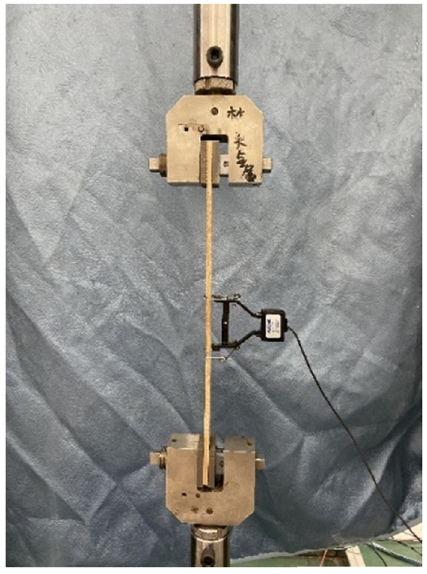
Figure 3: The creep experiment